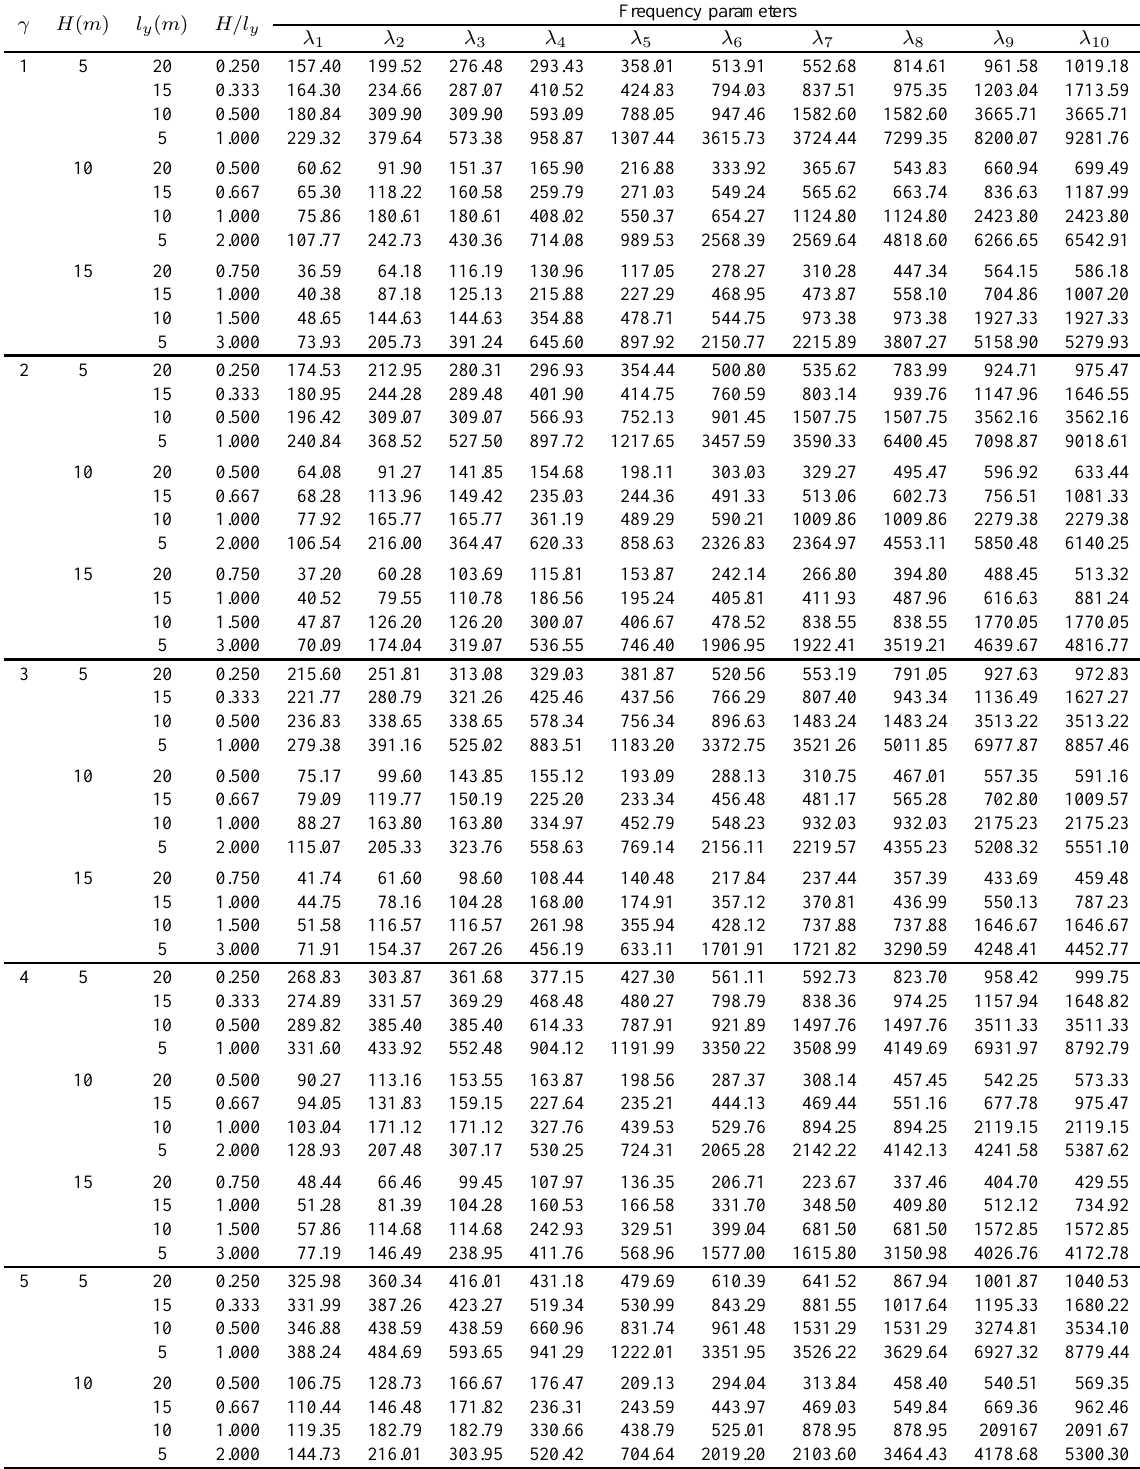
Table 1 First 10 frequency parameters of plates on elastic foundations for different values of H,H/l y and